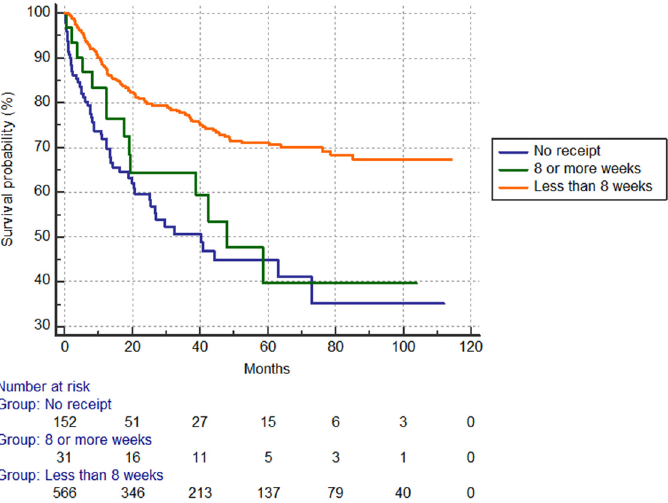
Fig 2. Recurrence-free survival according to use of adjuvant chemotherapy use. Five-year rates by group: 44.8% no chemotherapy; 39.6% delay (cid:1) 8 weeks; 71.2% < 8 weeks (p < 0.001).